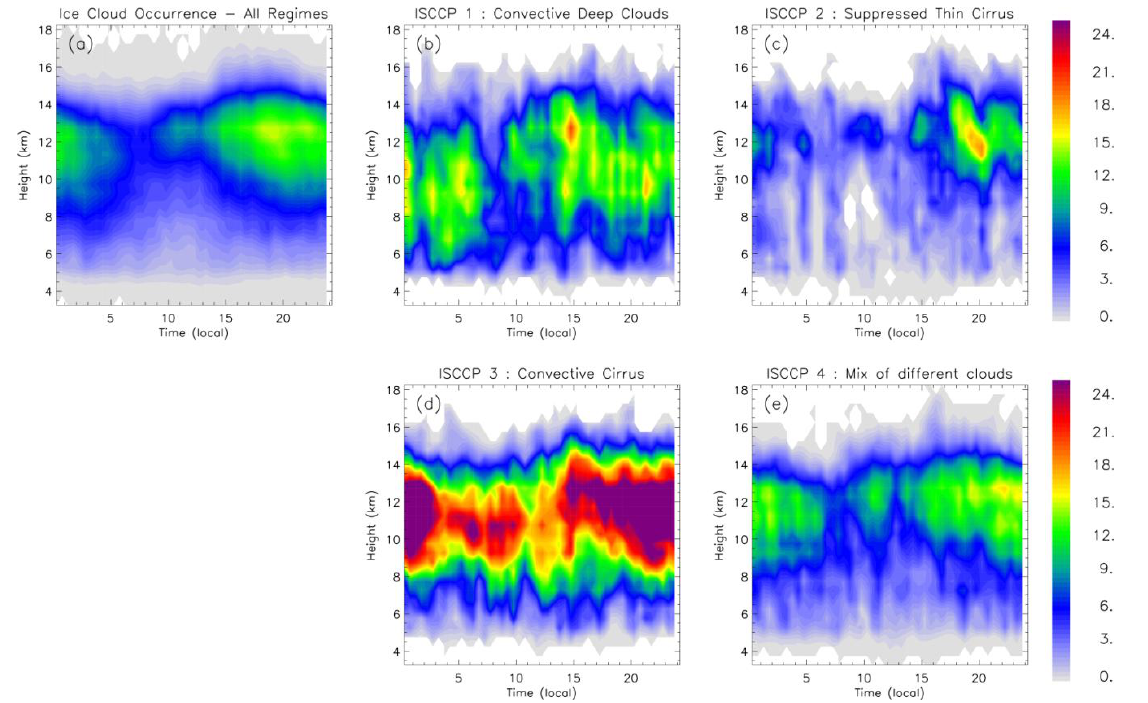
Figure 10: Same as Fig. 2 but for the ISCCP regimes: CD (b), STC (c), CC (d), and MIX (e). Fig. 10. Same as Fig. 2 but for the ISCCP regimes: CD (b) , STC (c) , CC (d) , and MIX (e)